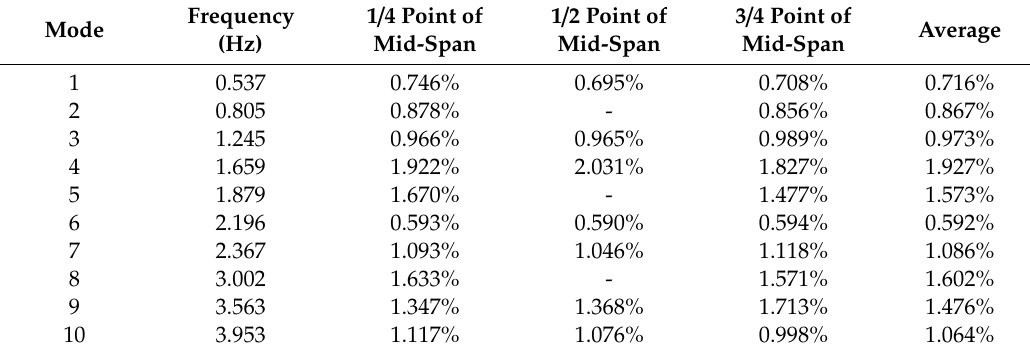
Table 4. Measured bending frequencies and estimated structural damping ratios.